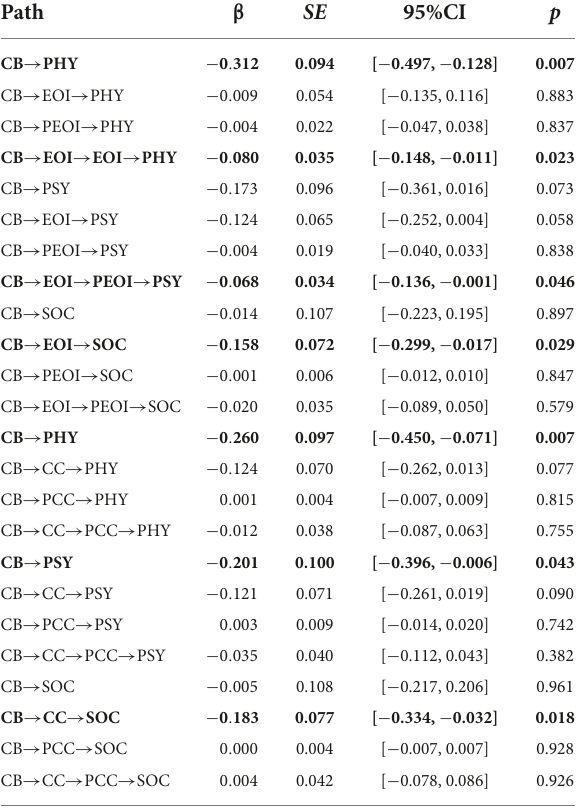
TABLE 3 Standardized mediating path